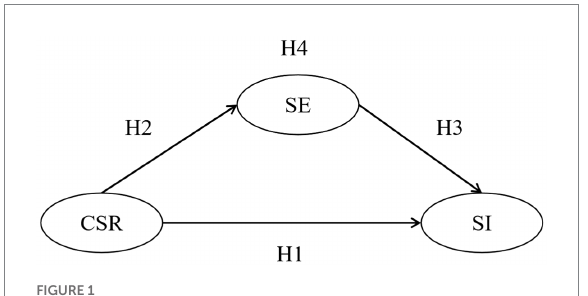
FIGURE 1 Research framework. CSR, corporate social responsibility; SI, service improvisation; SE,